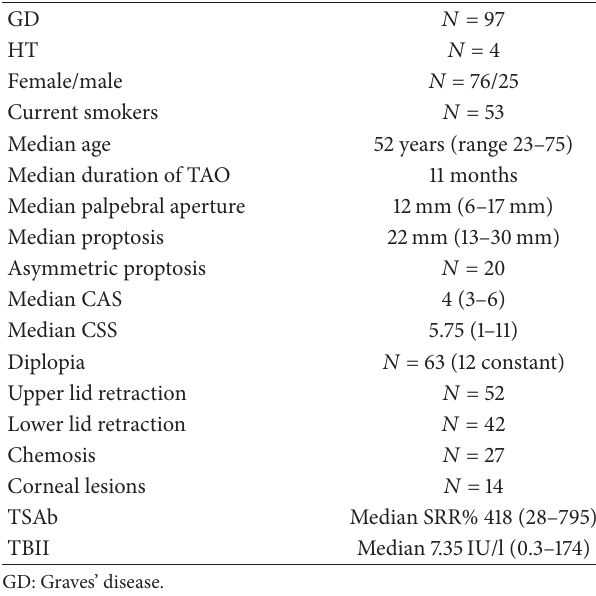
Table 1: Demographic, clinical, and serological data of the 101 consecutively included patients with severe and active TAO.